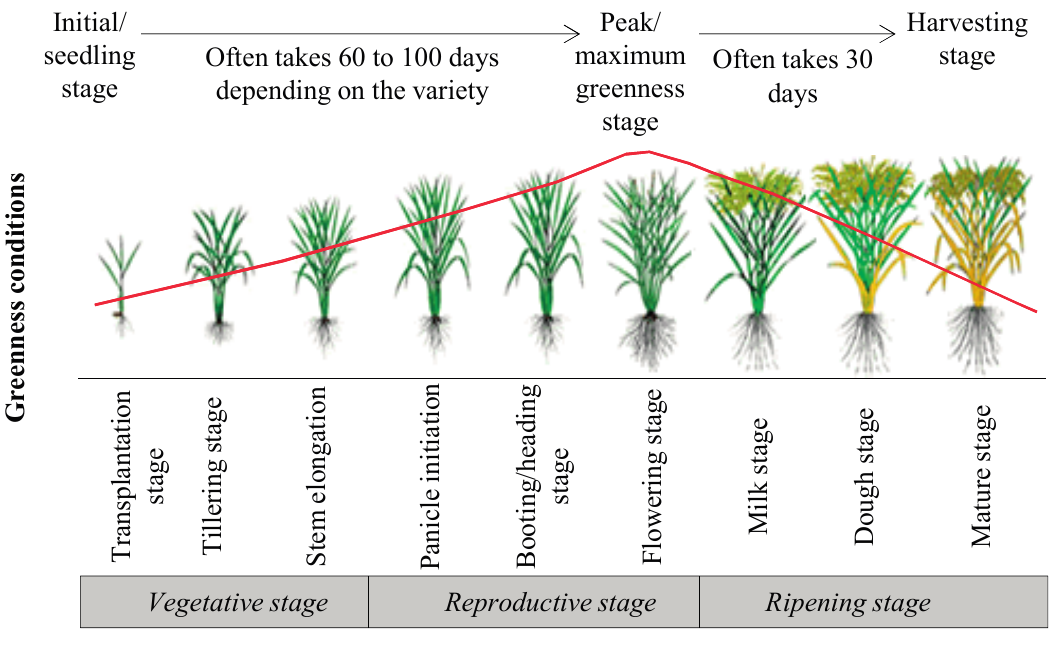
Figure 1. Growing stage of a typical rice crop and their associated greenness conditions (modified after [38]). The red curve shows a typical temporal dynamics of very commonly used remote sensing-based vegetation greenness index [ i.e. , normalized difference vegetation index